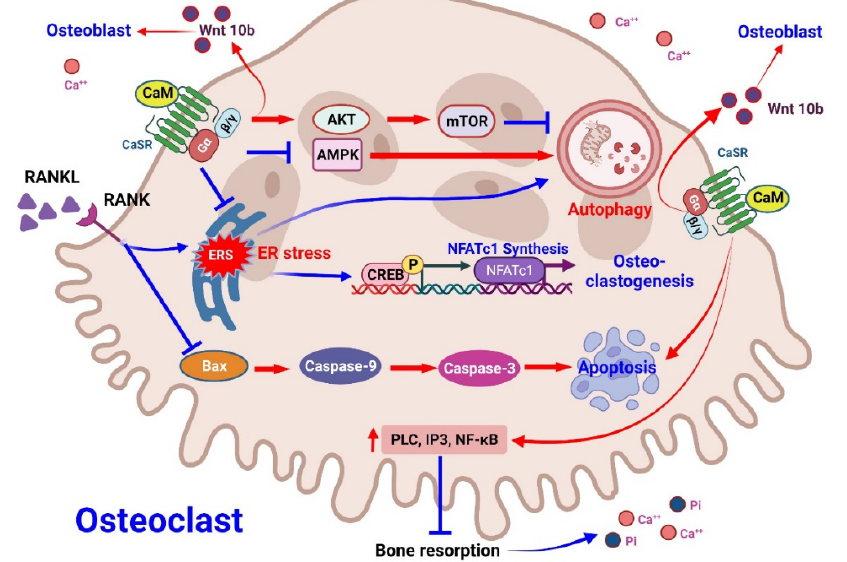
Figure 2. Molecular mechanism of CaMs on osteoclasts in CKD. Osteoblast and osteoclast prolifera- tion, differentiation, and apoptosis are influenced by local extracellular calcium concentrations. The activation of the RANK/RANKL signal from osteoblasts modulates osteoclastogenesis. The signal induces the elevation of endoplasmic reticulum stress (ER stress), which activates the cAMP response element-binding protein (CREB) phosphorylation. The downstream transcription of the nuclear factor of activated T cells, cytoplasmic (NFATc1) activates osteoclastogenesis. On the other hand, ER stress also activates the autophagy process to maintain osteoclast viability. RANK/RANKL also inhibits osteoclast apoptosis. CaMs induce the release of Wnt-10b from osteoclasts and inhibit the autophagy vial, activating the Akt/mTOR pathway. In this manner, CaMs increase bone formation, along with the apoptosis of the